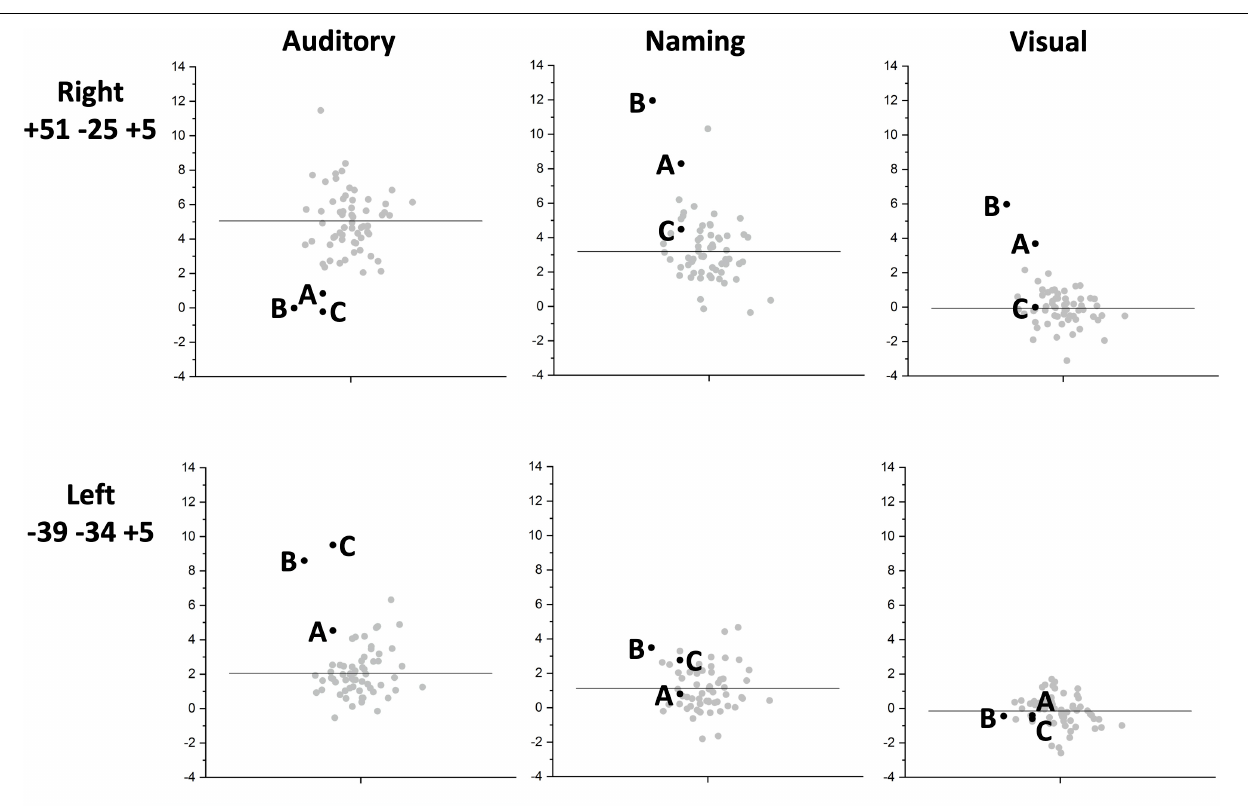
FIGURE 4 | Inter-subject task variability plots for the right and left temporal regions of interest. The plots show the individual responses for the three patients (black circles) and 61 neurotypical control participants (grey circles) for the right superior temporal [+51 − 25 +5] (upper row) and left superior temporal [ − 39 − 34 +5] (lower row) regions showing group differences. These are shown for each of the three fMRI tasks: auditory semantic matching (Auditory) (left column plots), object naming (Naming) (centre column plots) and visual semantic matching (Visual) (right column plots). The black horizontal line indicates the average response across the 61 NC. Y-axis represent the fMRI responses (first eigenvariate extracted from SPM).